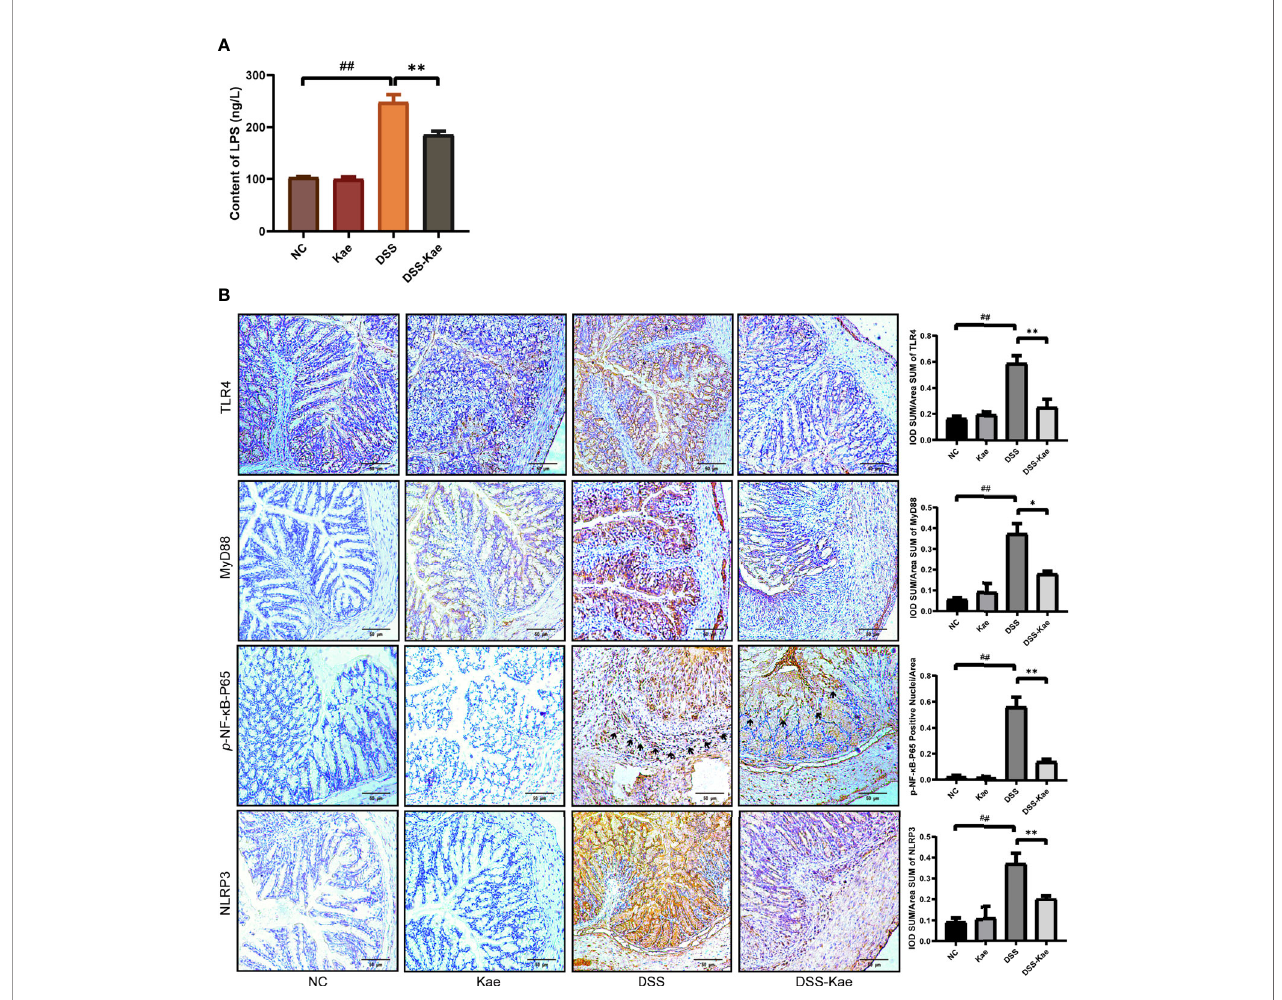
FIGURE 7 | Kae suppresses the LPS-TLR4-NF- k B signaling pathway. (A) Serum levels of LPS. (B) Immunohistochemical analysis of TLR4, MyD88, p -NF- k B-P65, and NLRP3 expression in colon tissues (scale bar, 50 m m). Positive protein integral optical density was analyzed using Image J 1.5.7 software. Data are expressed as mean ± SEM, n = 5, analyzed using one-way ANOVA with Tukey post-hoc analysis. DSS ( vs . NC, ## P < 0.01; vs . DSS-Kae, * P < 0.05, ** P < 0.01), ns, no signi fi cant